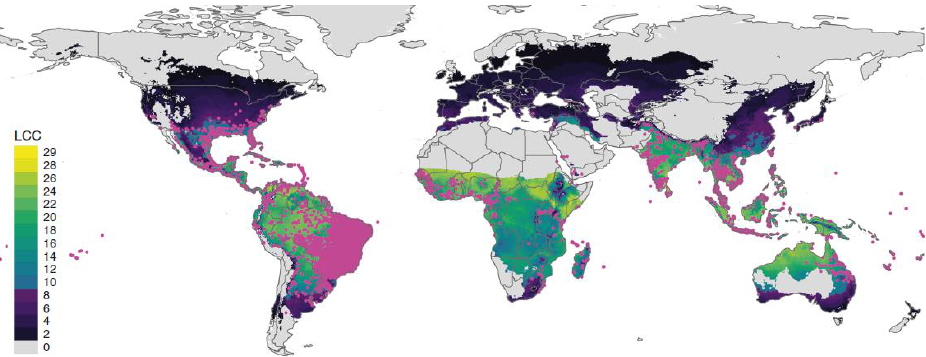
Figure 1. Aedes aegypti distribution worldwide. The map indicates the total number of annual life-cycle completions (LCC) of A. aegypti , with occurrence data overlaid. A. aegypti is a recognized competent vector for both DENV and ZIKV. Adapted with permission from Ref. [12]. Copyright 2020 Iwamura, T.; Guzman-Holst, A.; Murray, K.A. Overall, as the vectors responsible for infection spread to other than tropical and sub-